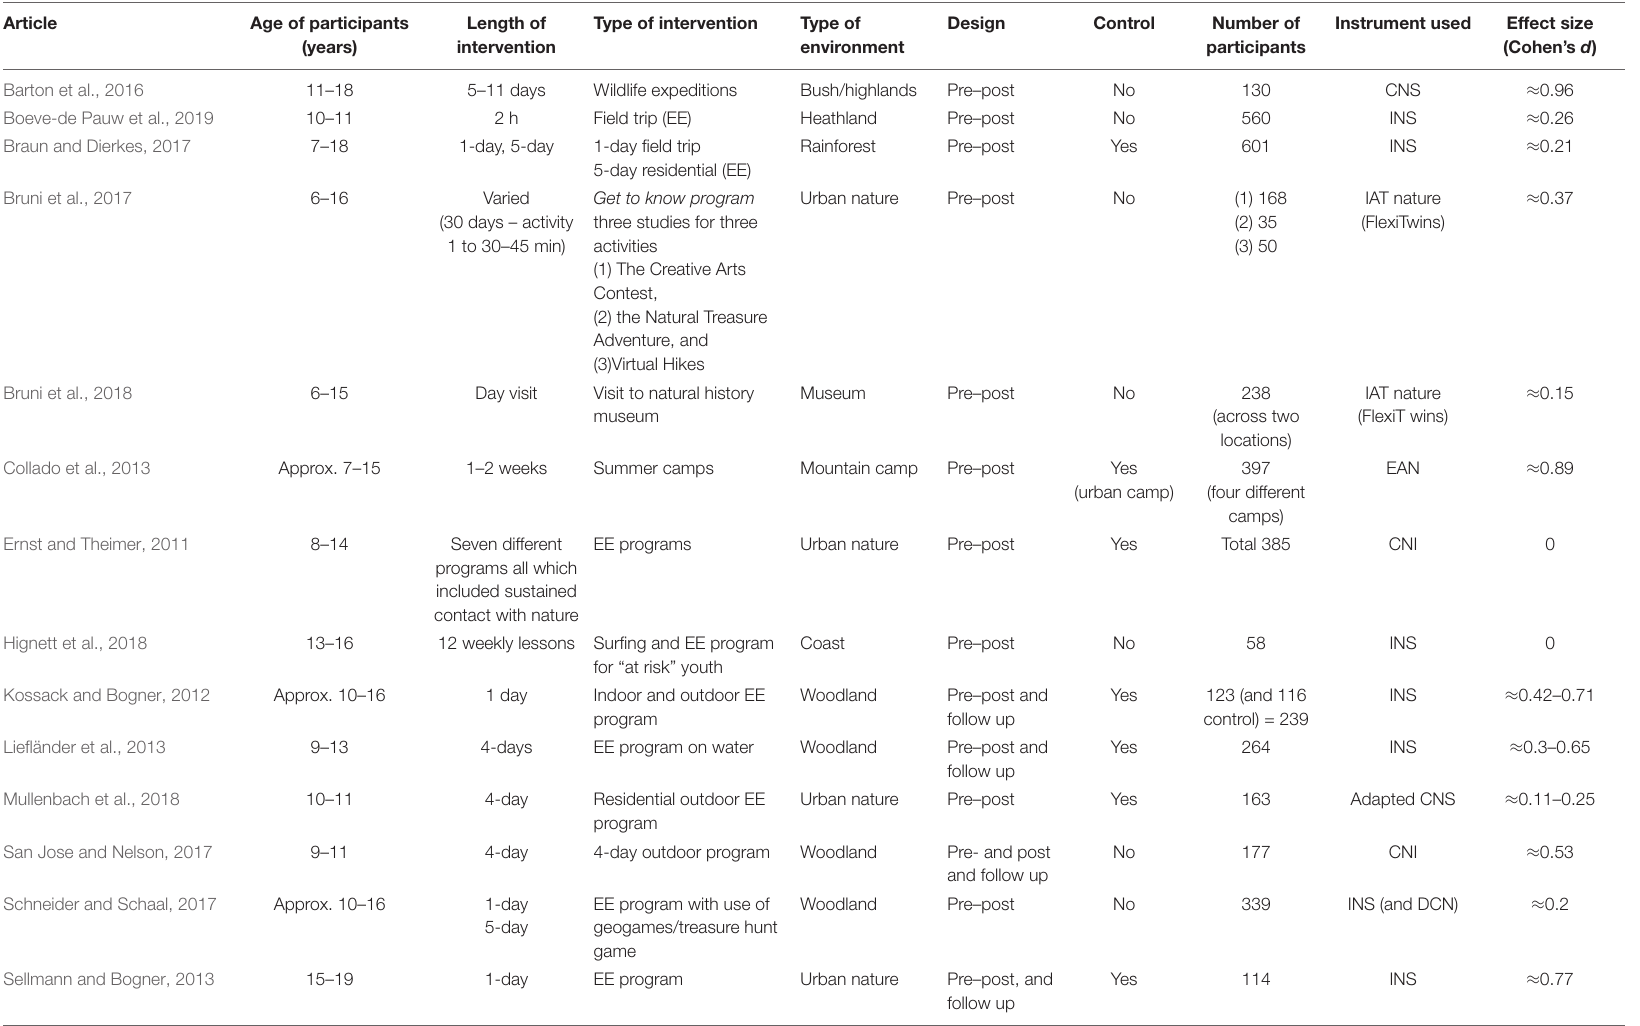
TABLE 1 | Interventions to increase nature connection as identified in